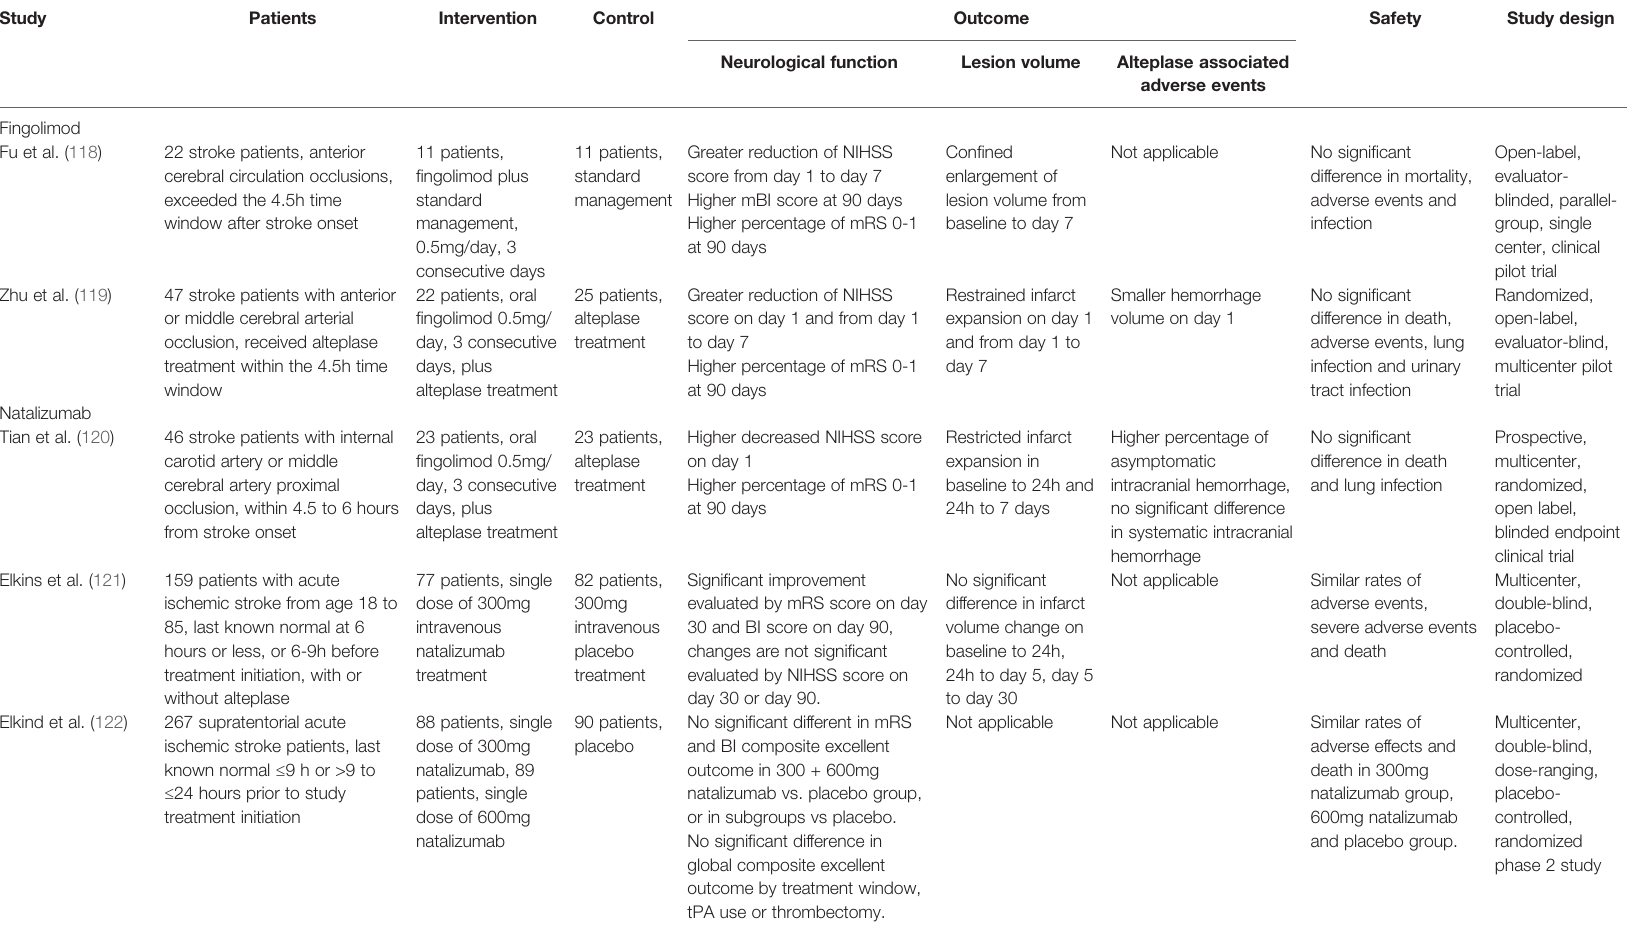
TABLE 4 | Clinical Trials of T cell targeted